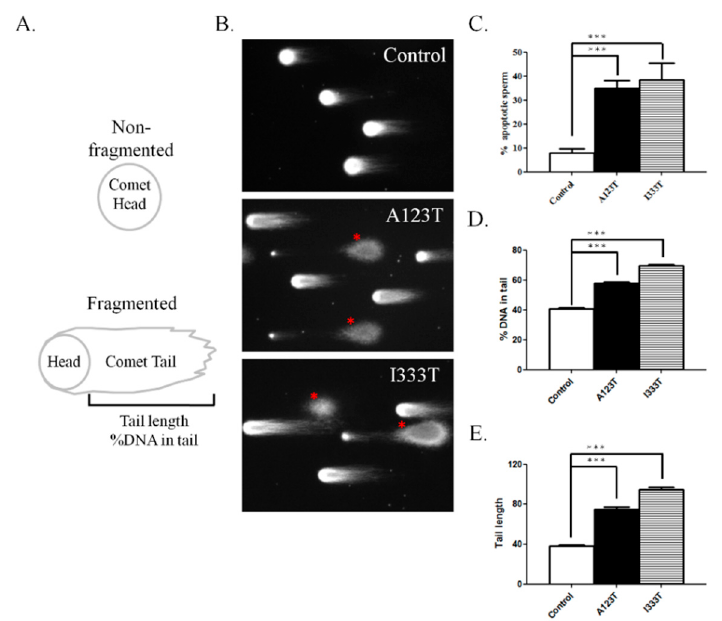
Figure 3. Infertile patients with SEPT14 mutations have significantly higher DNA fragmentation than controls. ( A ) Illustration of the comet content. DNA fragments migrated out of the heads and resemble a “comet tail” under electrophoresis. The intensity and length of the comet tail reflect the degree of DNA damage. ( B ) Representative images of DNA damage in sperm obtained from controls and patients with A123T or I333T. ( C ) Quantification of % apoptotic sperm number. ( D and E) Quantification of %DNA in the tail and tail length. Evident DNA damage was observed in sperm from infertile patients with SEPT14 mutations. All quantifications were performed on the control ( n = 6), A123T ( n = 3), and I333T ( n = 3) groups. * Significant difference compared with controls (***, p < 0.001, analyzed using Student’s t test).